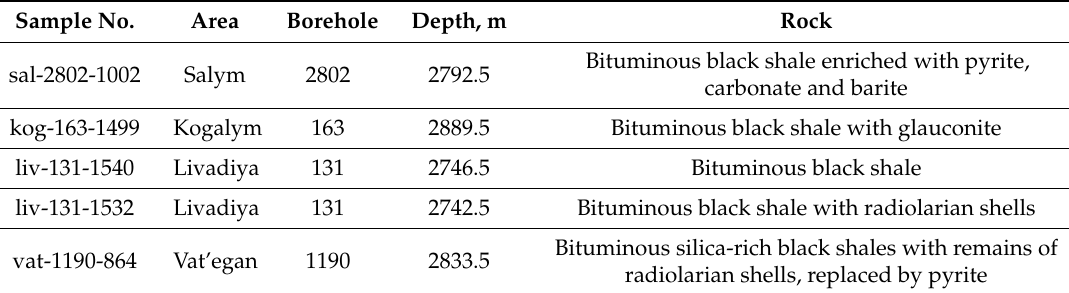
Table 1. The host rocks of the studied Bazhenov Formation